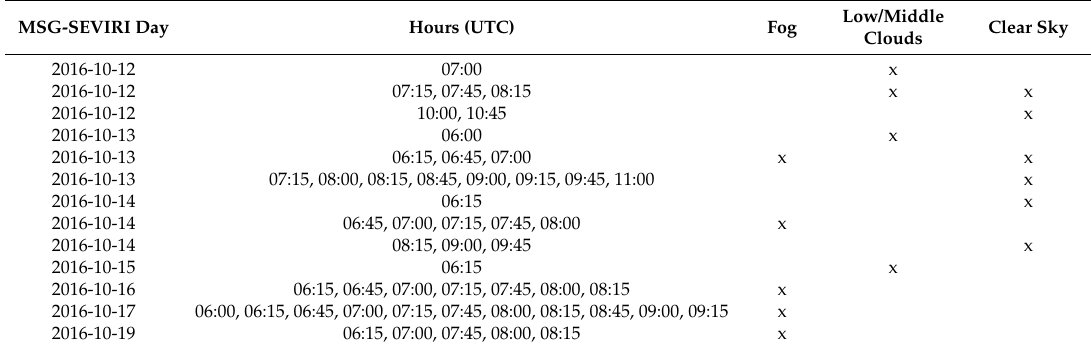
Table 2. Dataset used for thresholds determination.